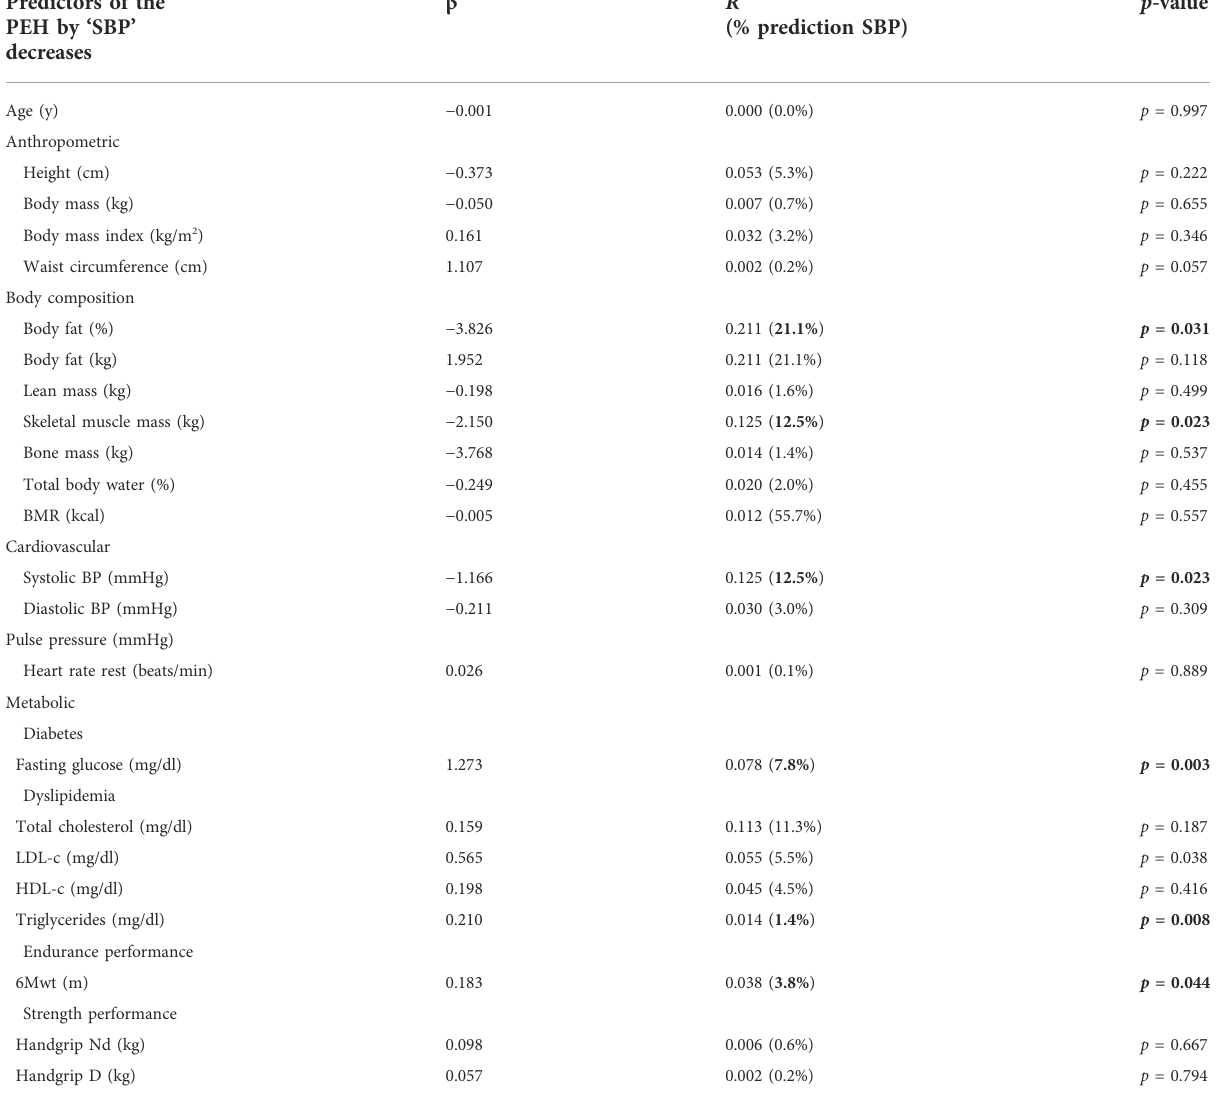
TABLE 3 Association between the PEH represented by “ SBP ” decreases with anthropometric, body composition, cardiovascular, metabolic, dyslipidemia, endurance, and strength performance outcomes in morbid obesity patients ’ participants of 20 weeks of two orders of concurrent training (ET + RT or RT +